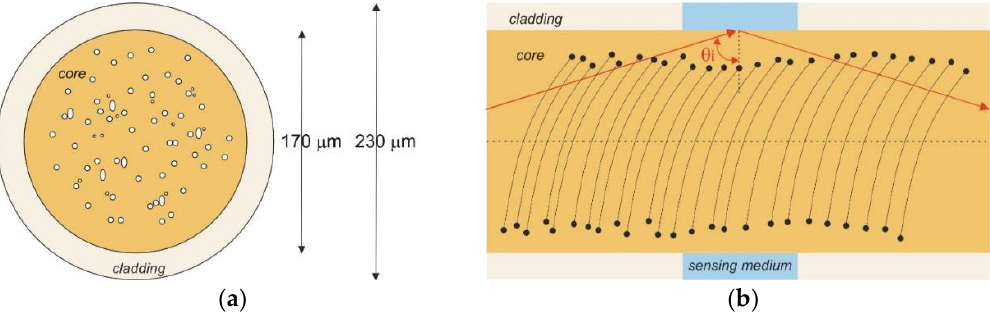
Figure 1 . ( a ) Schematic cross-section of the light-diffusing fiber (LDF) used for surface plasmon resonance (SPR) sensing; ( b ) Schematic lateral view of the LDF used for SPR sensing, showing the portion of unclad fiber.